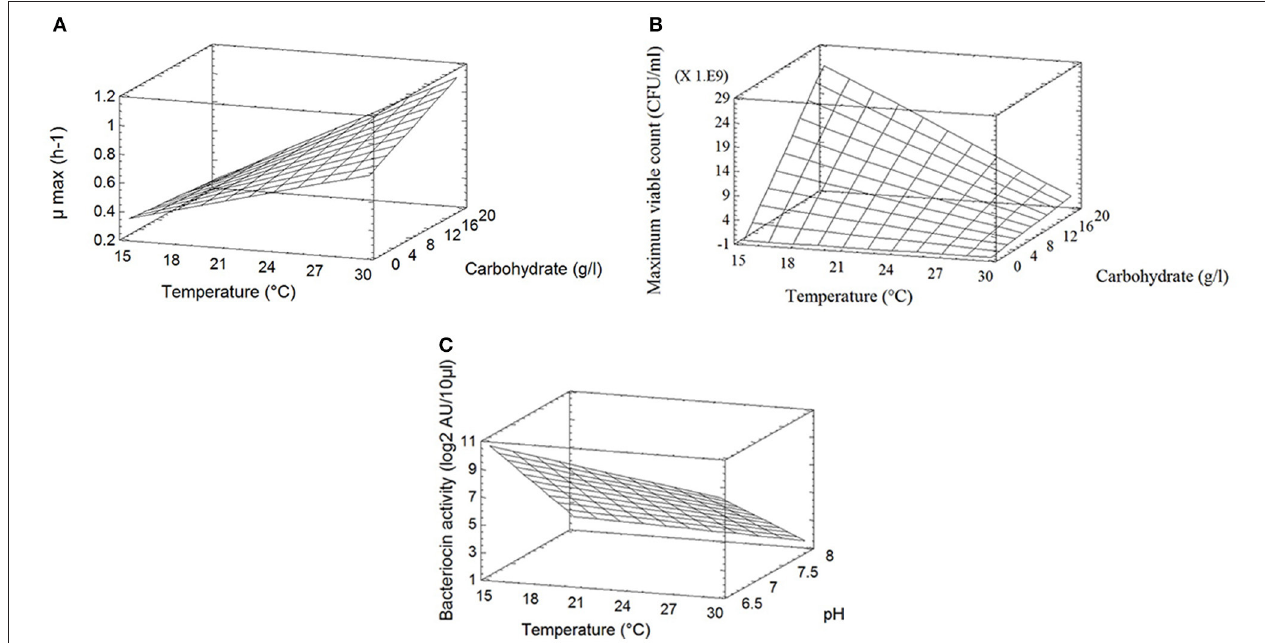
FIGURE 1 | (A) Response surface of the maximum growth rate µ max (h − 1 ) of C. divergens V41 as a function of temperature and carbohydrates concentration at pH 6.5. (B) Response surface of the maximum bacterial count (CFU/ml) of C. divergens V41 as a function of temperature and carbohydrates concentration at pH 6.5. (C) Response surface of the bacteriocin production (log 2 AU 10/ µ l) by C. divergens V41 as a function of temperature and pH with a carbohydrates concentration of 2g/l. L. monocytogenes RF76 was used as the indicator